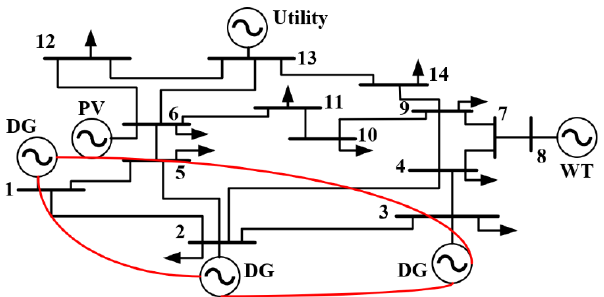
Figure 6. Microgrid Model and communication links between DDGs in the normal operation.